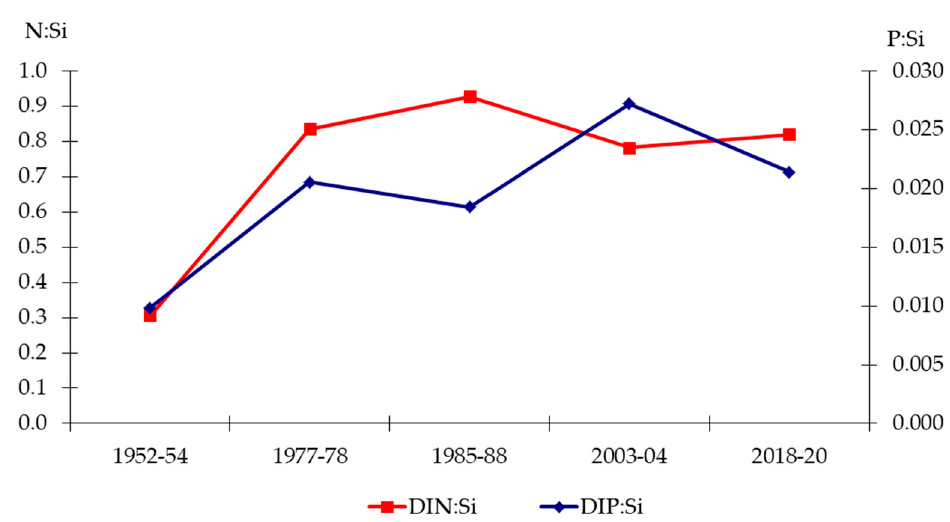
Figure 14. Long-term changes in an atomic ratio of inorganic nitrogen and phosphorus to silicate [13,67,68].